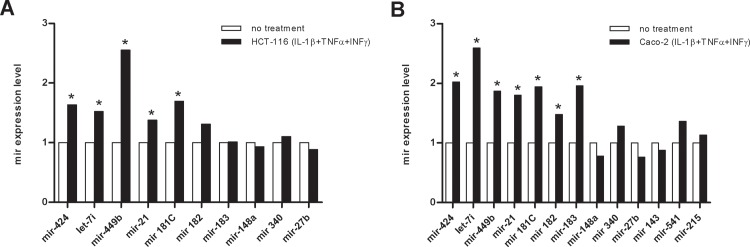
Inflammatory conditions induce increased miRNA expression in intestinal epithelial cells.(A) HCT-116 and (B) Caco2 cells after incubation with pro-inflammatory cytokines. Relative microRNA expression alterations were calculated for each tested microRNA (mir) after treatment with IL-1β, TNF-α, and INF-γ, compared to the expression level of the corresponding untreated cells. *P <0.05.